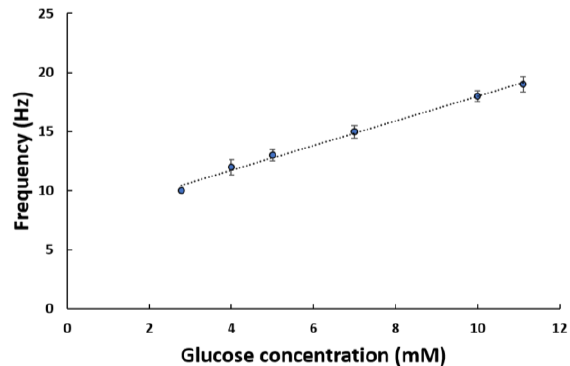
Figure 5. Dependence of the average charging/discharging frequency of the capacitor on glucose concentration, as measured with the self-powered glucose biosensing system operating in human plasma glucose (2.78–11.11 mM). Error bars represent the standard deviation of the measurements from triplicate testing.